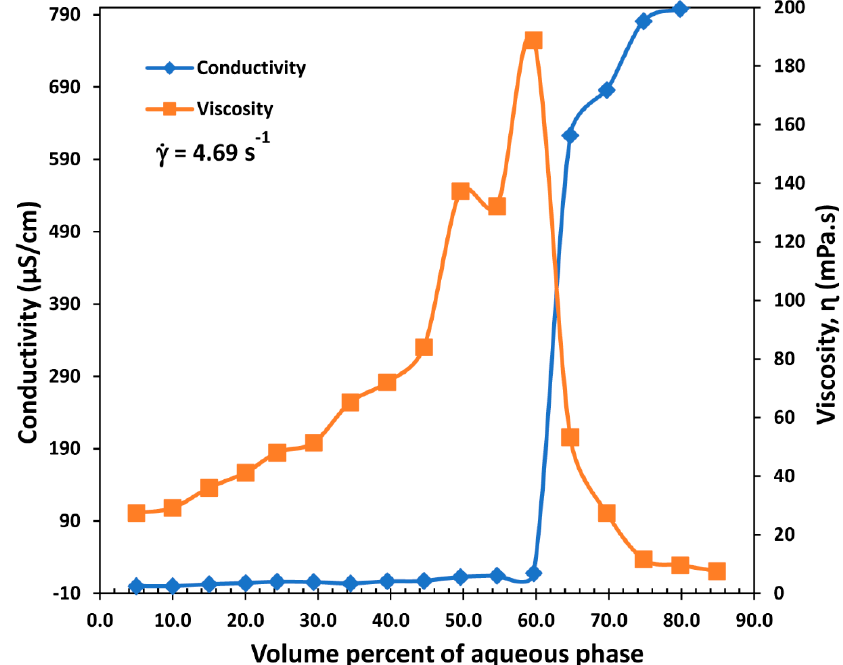
Figure 13. Variations of electrical conductivity and viscosity of emulsion with the increase in aqueous-phase concentration. SNP concentration of aqueous phase is 2% wt.